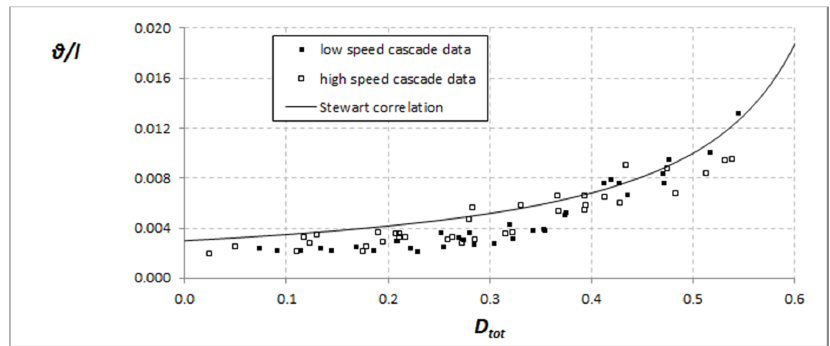
Figure 2. Matching of cascade experiments [15] to momentum thickness correlation [14] by means of an equivalent diffusion factor based on Equation (3).